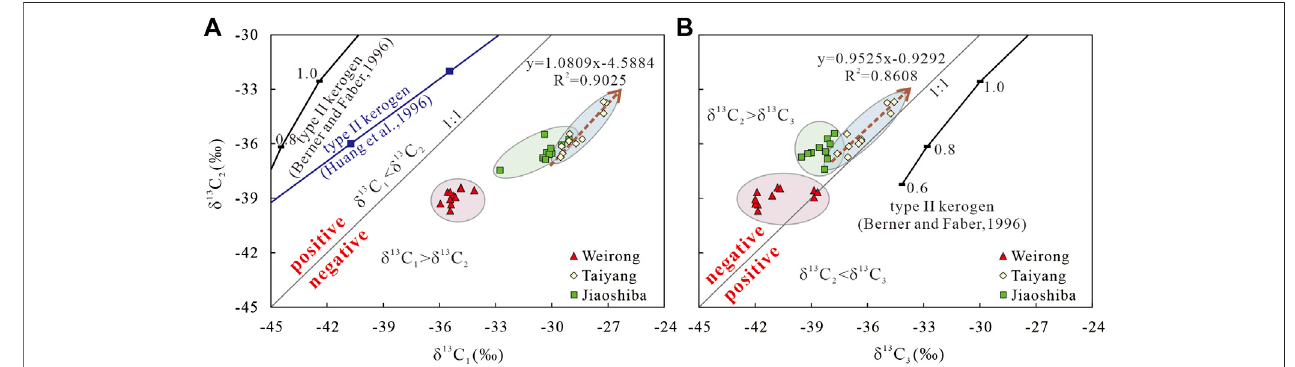
FIGURE5| δ 13 C 1 versus δ 13 C 2 (A) cross-plotand δ 13 C 2 versus δ 13 C 3 cross-plot (B) ofgasesfromTaiyang,Jiaoshiba,andWeironggas fi eldsintheSichuanBasin. Lines ofType IIkerogen fromBerner and Faber(1996) and Huanget al.(2016) arealso shown. Forthe linefromBerner and Faber (1996),thecarbon isotopeofthe initial precursor is estimated to be − 29 ‰ .